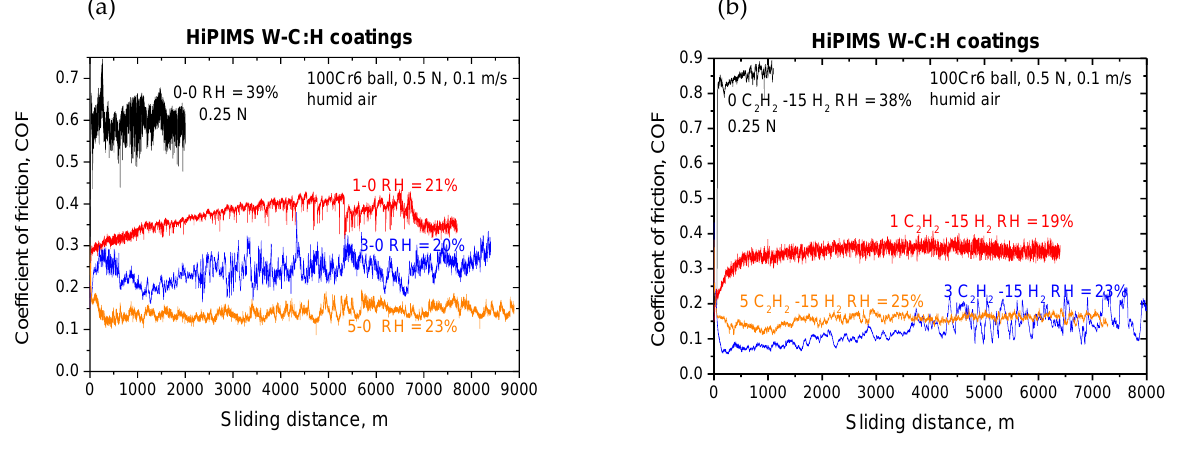
Figure 5. Friction curves obtained in humid air in the studied W-C:H coatings deposited with different flows of ( a ) C 2 H 2 and ( b ) C 2 H 2 + 15 sccm H 2 . The abbreviations at the individual curves refer to the flows of C 2 H 2 and H 2 in the sputtering atmosphere during deposition.